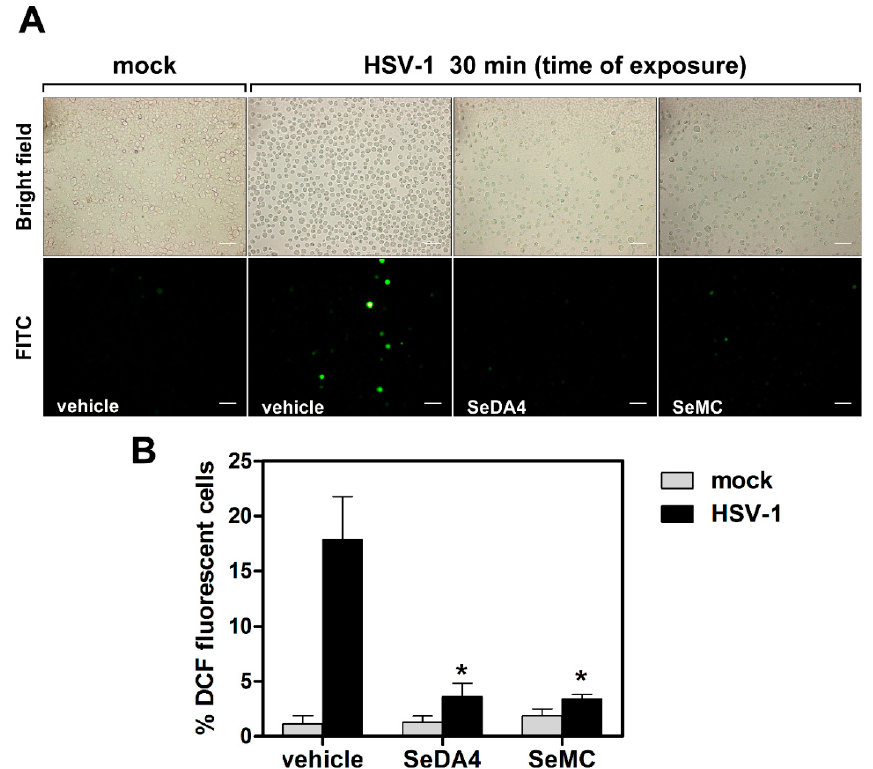
Figure 6. Effects of selenium-based antioxidants on early ROS induction by HSV-1. U937 cells were incubated with SeDA4 (20 µM), SeMC (20 µM) or vehicle alone for 48 h and then preloaded with DCFH-DA before exposure to HSV-1 (MOI = 50 PFU/cell) for a further 30 min and successive fluorescence microscopy analysis. ( A ) Representative images in bright-field (upper panels) and FITC (bottom panels) of cells subjected to different experimental conditions are displayed. Objective 20×, scale bar = 50 µm. ( B ) % of DCF fluorescence positive cells (mean + S.D.) from 6 frames randomly selected from two independent experiments (3 frames each). * p < 0.001 vs. control HSV-1-infected cells (vehicle).